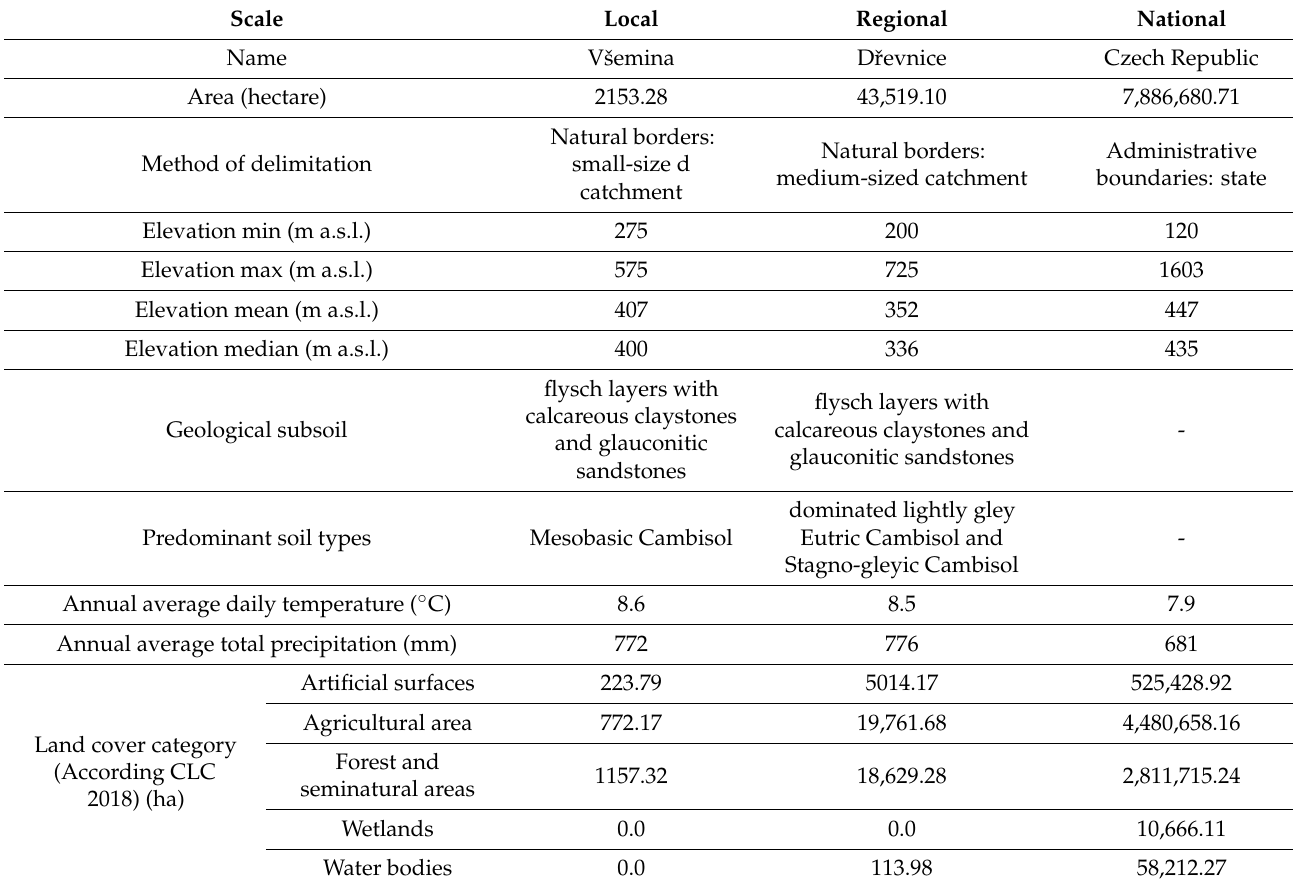
Table 1. Characteristics of the study